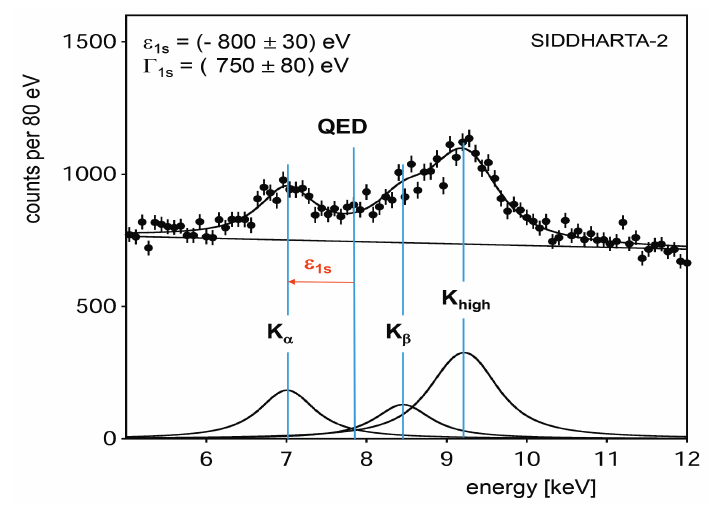
Figure 8: Kaonic deuterium spectrum simulated for SIDDHARTA-2 setup for an inte- grated luminosity of 800 pb − 1 . The simulation was carried out assuming a shift (cid:34)